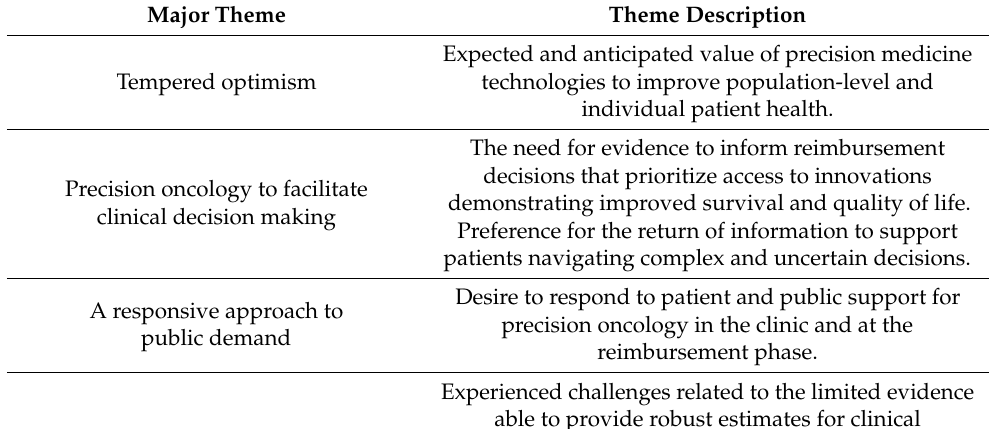
Table 3. Themes identified through thematic analysis of